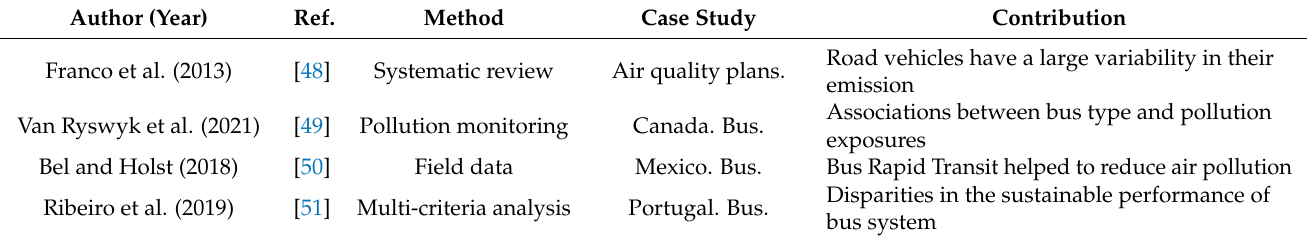
Table 1. Literature review on bus emissions and policies to reduce air